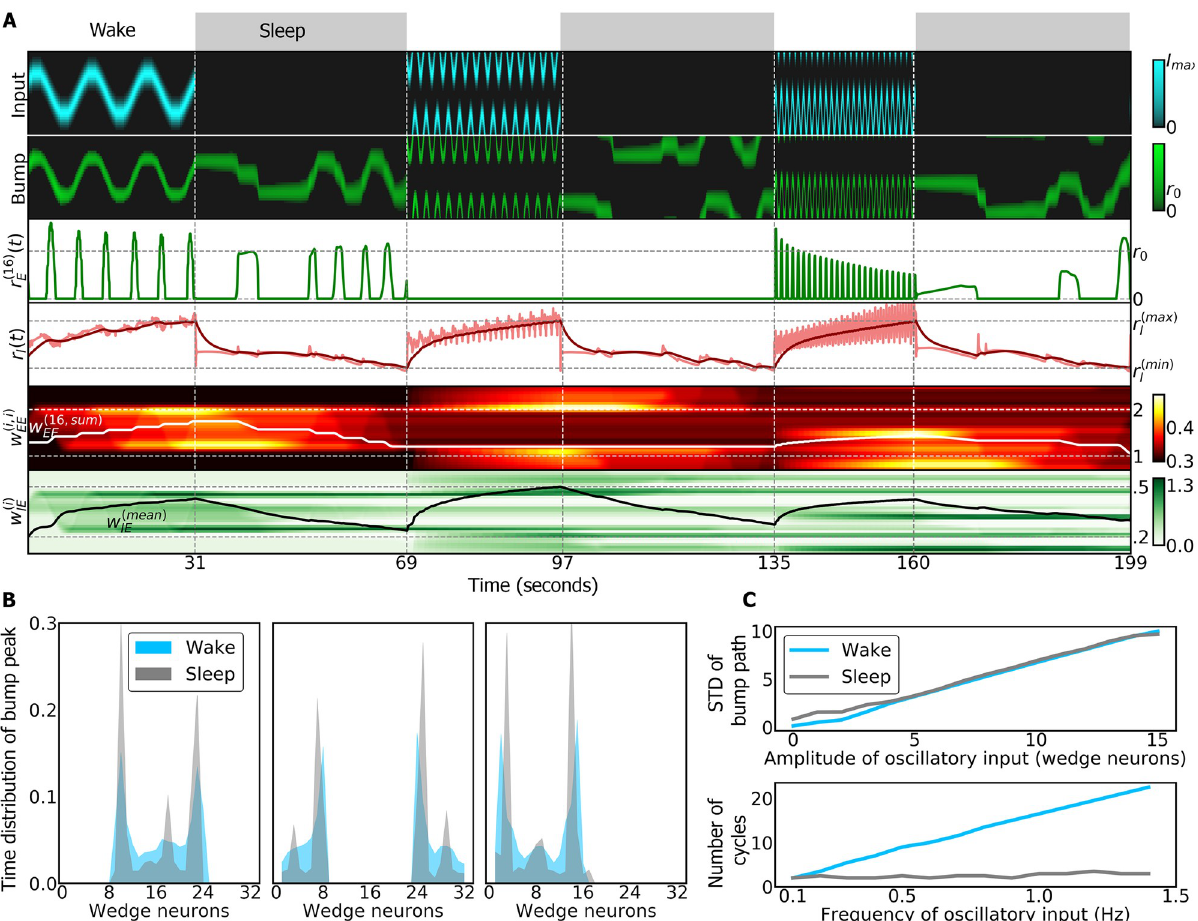
Fig 6. Relation between wake and sleep dynamics in the ring attractor network. A: In each wake phase, a sinusoidal input is provided to the ring attractor (top row) with increasing frequency in consecutive wake phases. During sleep, an autonomous bump of activity revisits wedge neurons active in the previous wake phase (second row). The third row shows the activity of wedge neuron 16 and the fourth row shows the activity of the ring neuron (light red) and its filtered activity (dark red) used to switch between wake and sleep phases. The last two rows represent the synaptic weights that increase during wakefulness and decrease during sleep. B: Normalized distribution of time that the bump peak is localized in each wedge neuron during wake (blue) and sleep (grey) phases. The first, second and third plots show the distribution for the first, second and third wake and sleep phases, respectively. C: Top: standard deviation (STD) of the bump path during a total of 15 simulations where different amplitudes of a sinusoidal inputs are provided during the wake phase. During the wake phase, the STD of the bump path is proportional to the input amplitude (grey). During sleep, the autonomous bump path has a correlated STD (Pearson correlation coefficient: 0.99; p = 1.5 � 10 − 17 ). Bottom: number of cycles of the bump path during a total of 15 simulations with different frequencies of a sinusoidal input during wake phase. During the wake phase, the number of cycles is proportional to the input frequency. However, during sleep, the number of cycles does not change with the input frequency. different frequencies in each wake phase (0.1, 0.5, and 1 Hz). During sleep, the bump revisits wedge neurons that were active in the preceding wake phase, as seen in the distributions of the time spent around each wedge neuron during the first (left), second (center) and third (right) wake phase (in blue), and during the following sleep phase (in grey) (Fig 6B). To further probe the amplitude dependence, we simulated a wake phase and the subsequent sleep phase, and in each simulation varied the amplitude A of a sinusoidal input in the range [0, 16], with fixed fre- quency of f = 1 Hz , during the wake phase. The standard deviation (STD) of the paths of the bump during the wake (blue) and sleep (grey) phases closely match (Fig 6C). Similarly, we investigated the frequency dependence with a stimulus with fixed amplitude, A = N /4, and varying frequency in the range [0.1, 1.5] Hz . The number of oscillatory cycles grows linearly